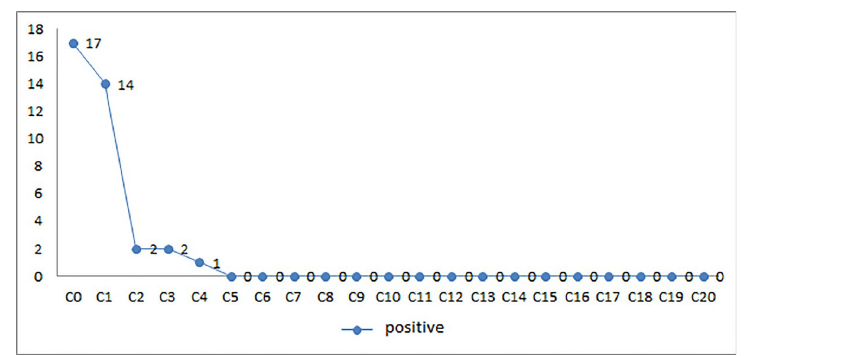
Fig 2. Bacteriological evolution of patients according to cultures.